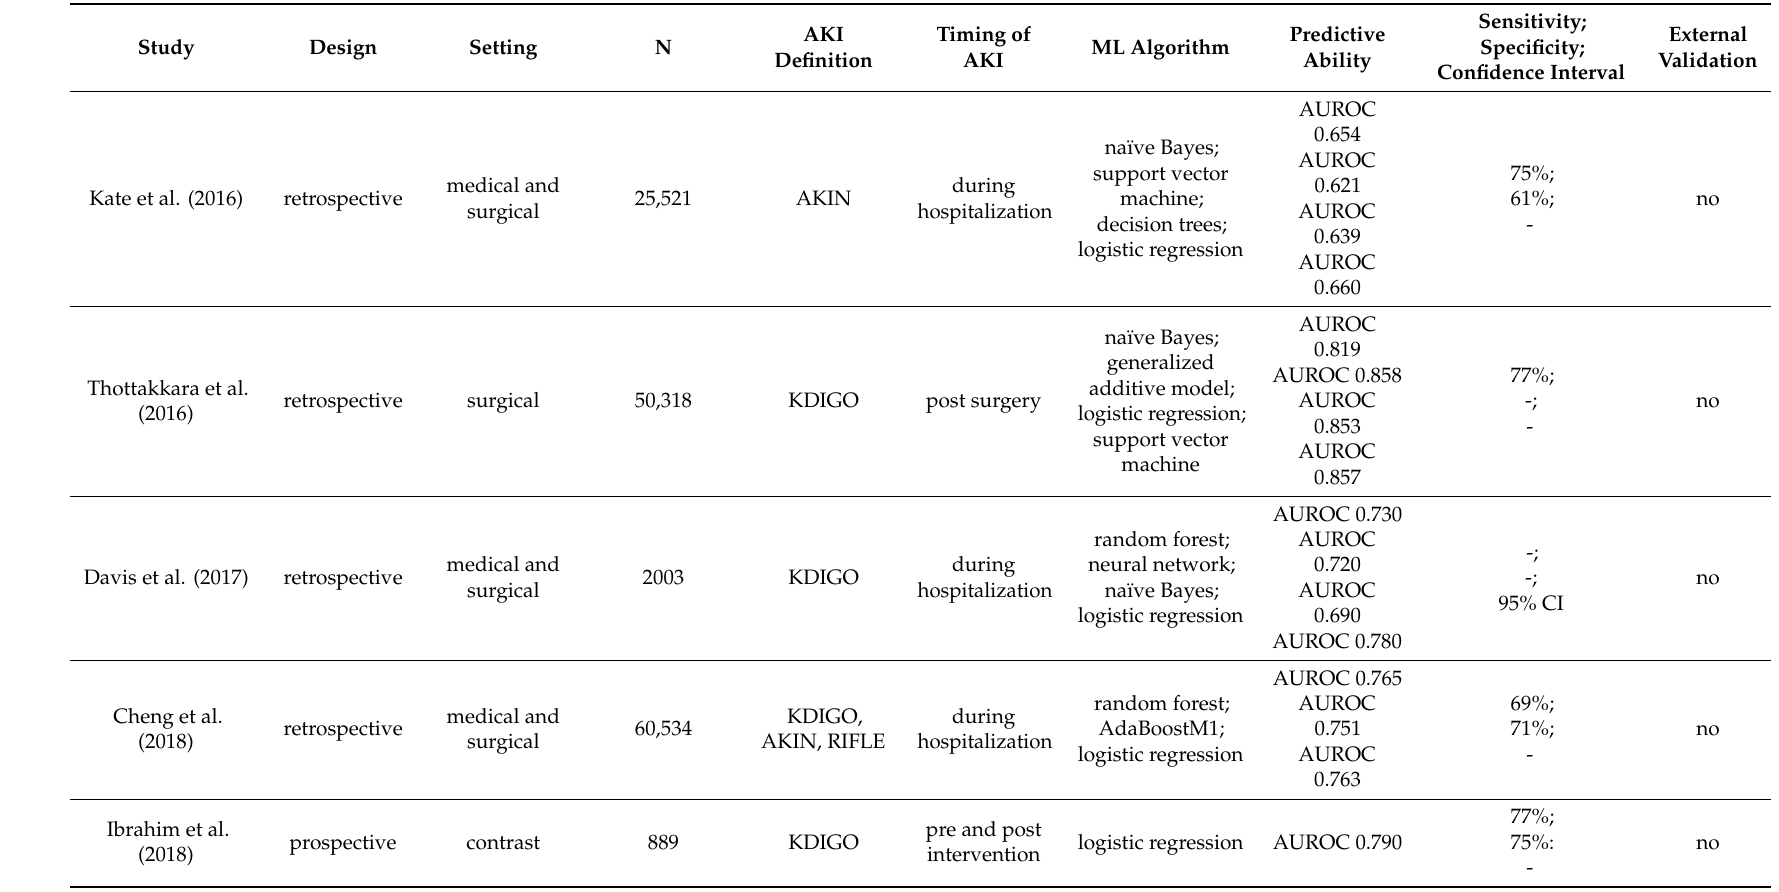
Table 1. Machine learning studies on acute kidney injury (AKI)